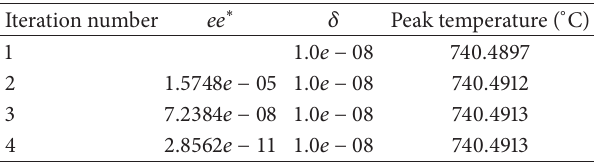
Table 3: Iterative process of the axial heat transfer correction.